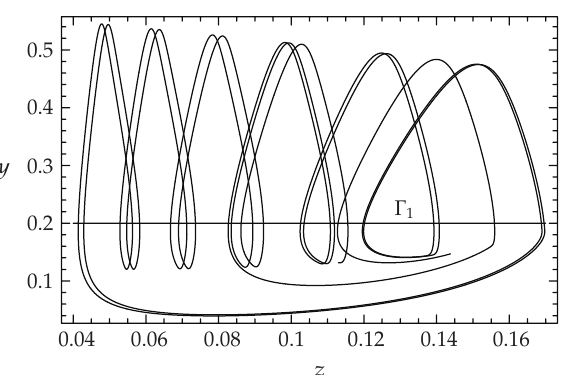
Figure 2: Projection of the three-dimensional trajectory onto the zy -plane for (cid:3) (cid:7) 0 . 4 and δ 2 (cid:7) 0 . 65.